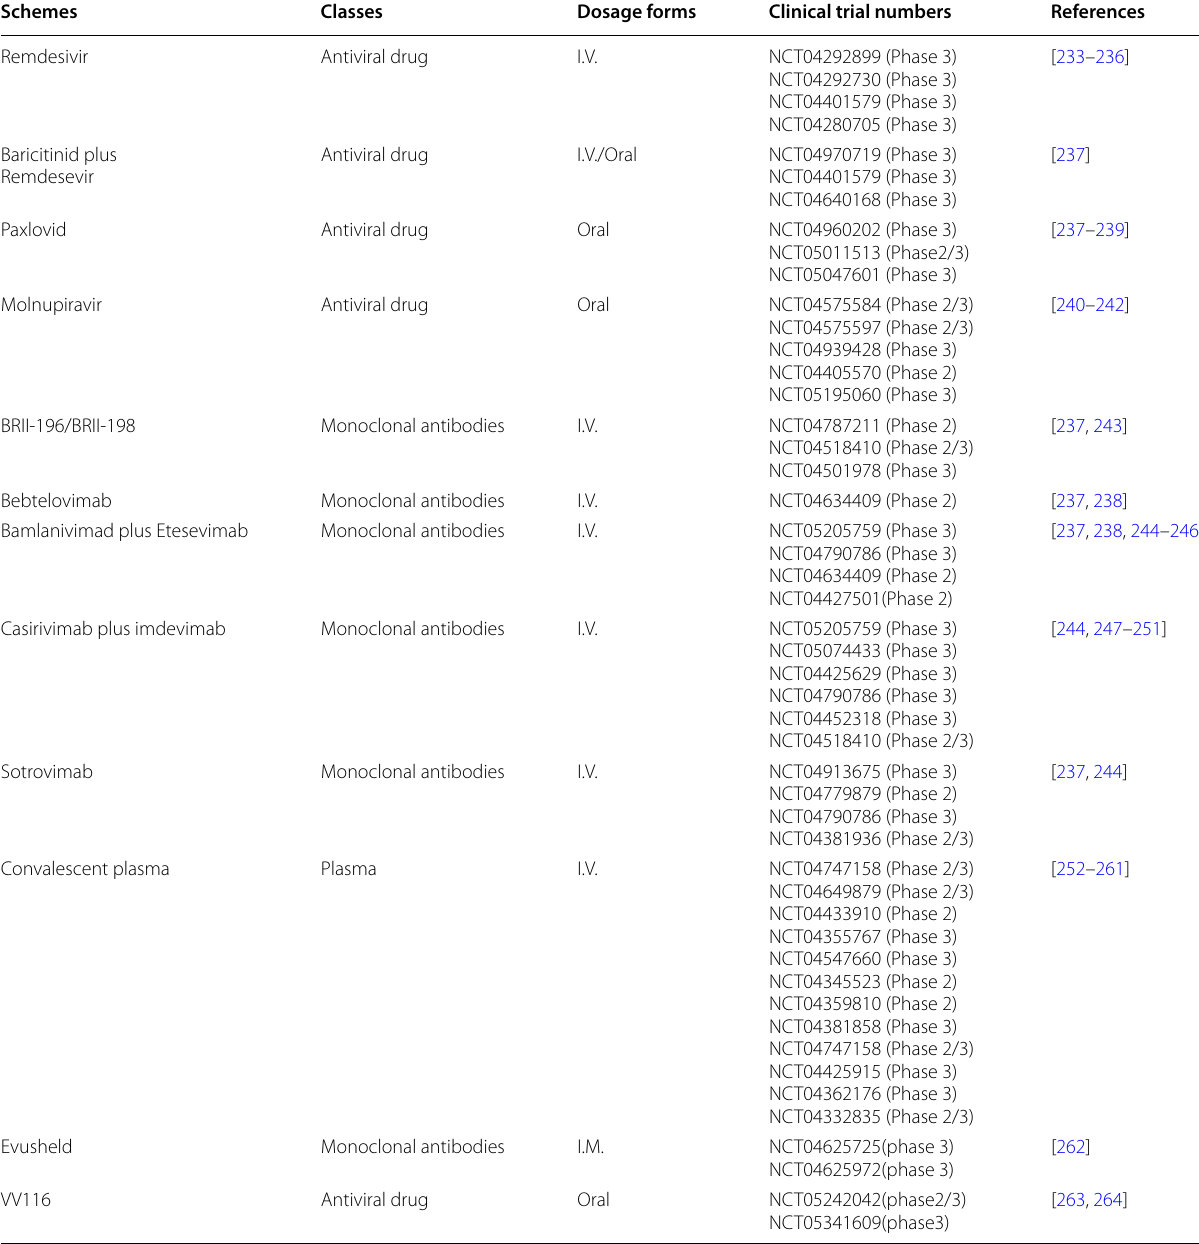
Table 1 The urgent approved drugs for COVID-19 treatment